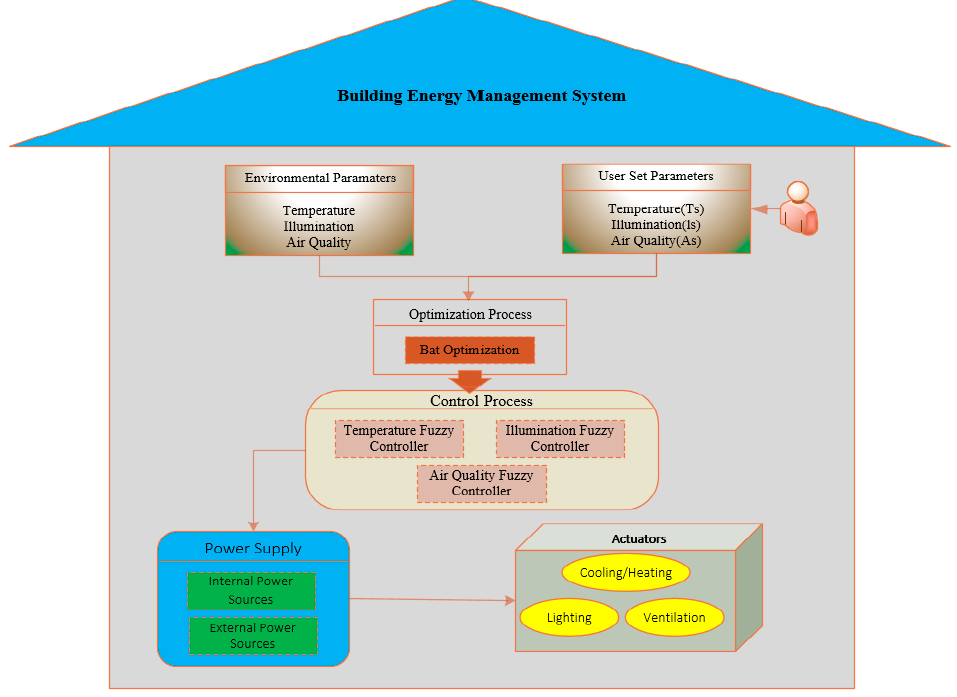
Figure 1. Proposed building energy management model.